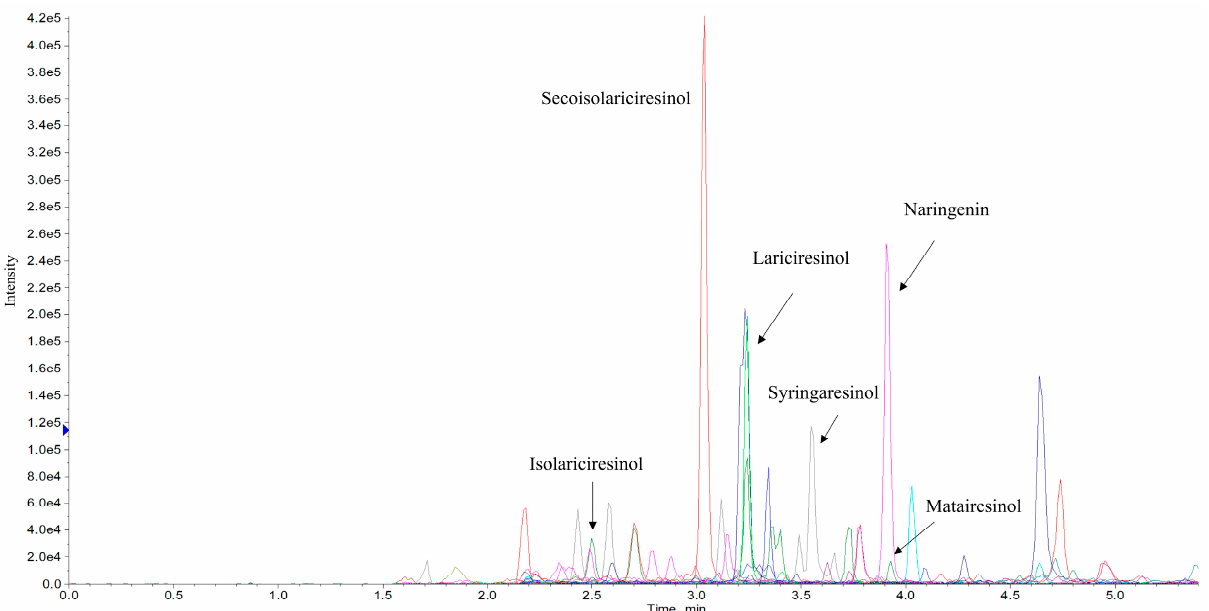
Figure 5. Representative chromatogram of Cannabis sativa L. variety Futura 75 Extract 3, showing lignans (lariciresinol, syringaresinol, isolariciresinol, matairesinol and seacoisolariciresinol) and isoflavone (naringenin).